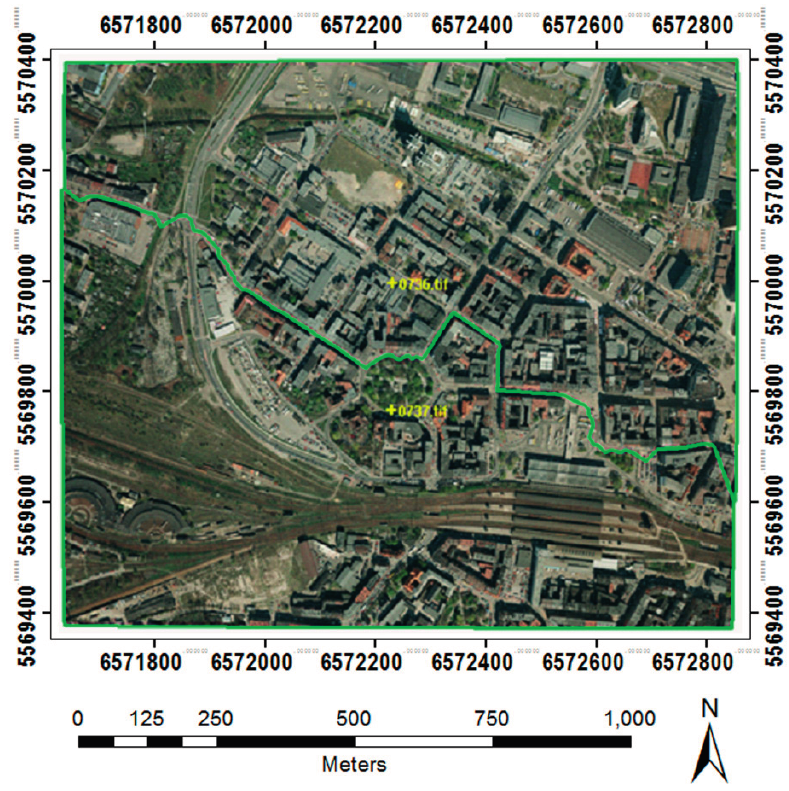
Figure 9. Mosaic result of the two DOMs. The green lines show the determined effective mosaic polygons (EMPs) for the images. The yellow crosses and characters indicate the nadir points and file names of the